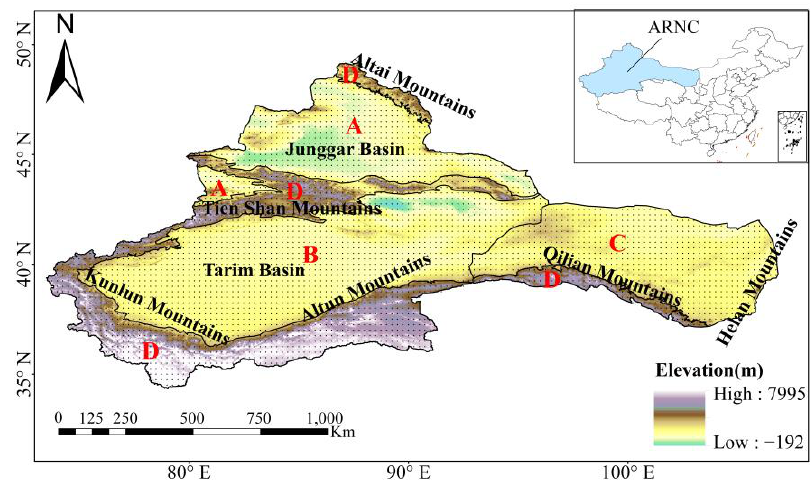
Figure 1. Geographical distribution map of the ARNC and subregions (A, north of Xinjiang; B, south of Xinjiang; C, Hexi corridor; D, mountain area).